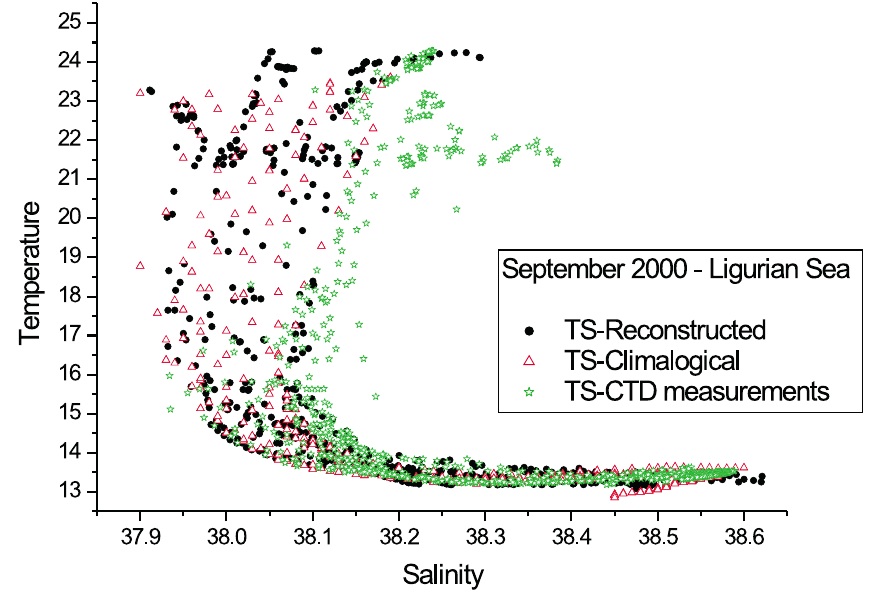
Fig. 3. T–S diagram comparisons among CTD, climatology and XBT- synthetic salinities during Septem- ber